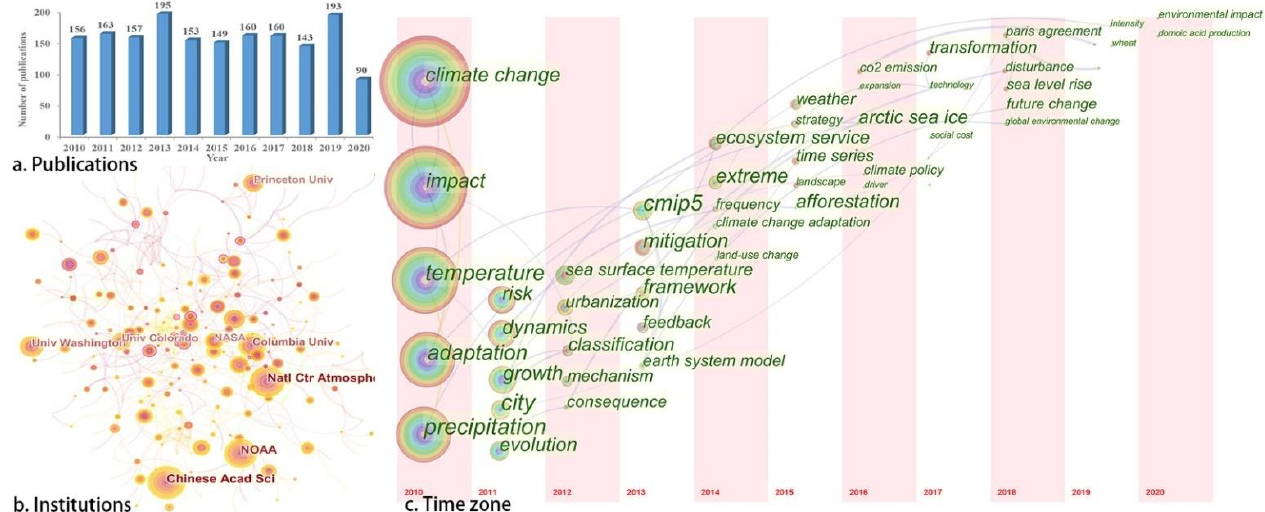
Figure 1. Overview of land research in the telecoupled world from 2010 to 2020: ( a ) publications, ( b ) institutions, ( c ) time zone.